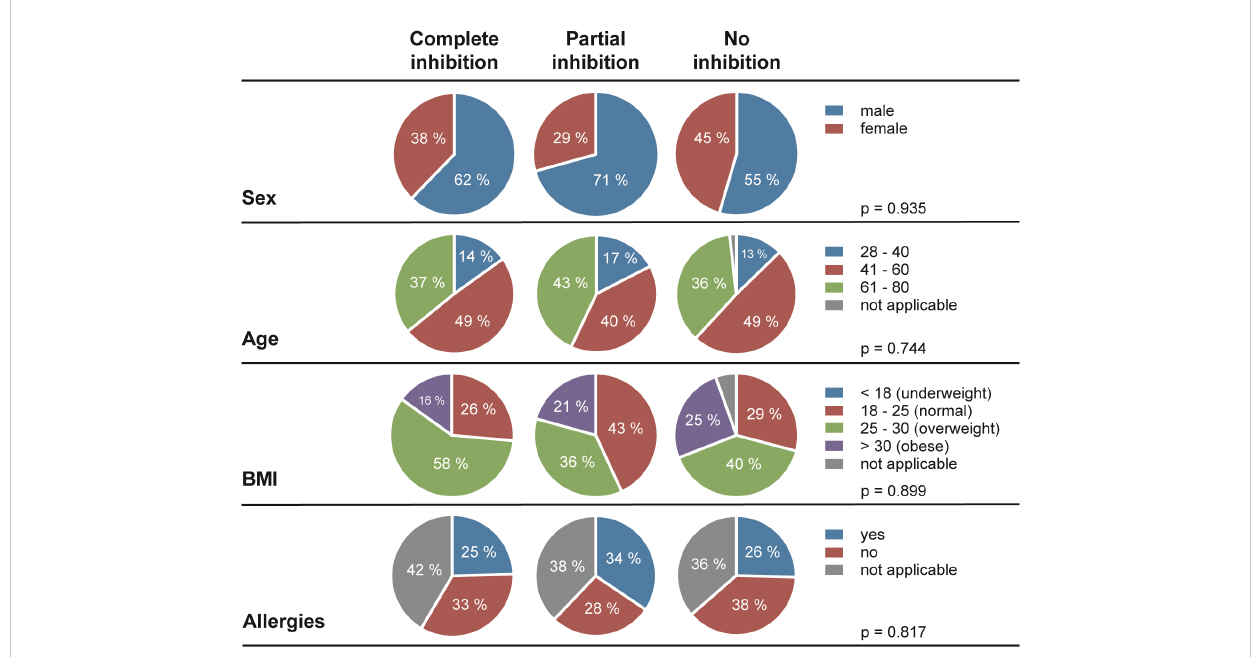
FIGURE 3 Demographic characteristics of the study cohort. In total, 158 of HSV-1 positive blood donors (complete inhibition, n = 47; partial inhibition, n = 58 and no inhibition, n = 53) were participated the retrospective survey. Differences between the three cohorts in terms of sex, age, Body-Mass-Index (BMI), and allergies were statistically evaluated using a Two-way analysis of variance test